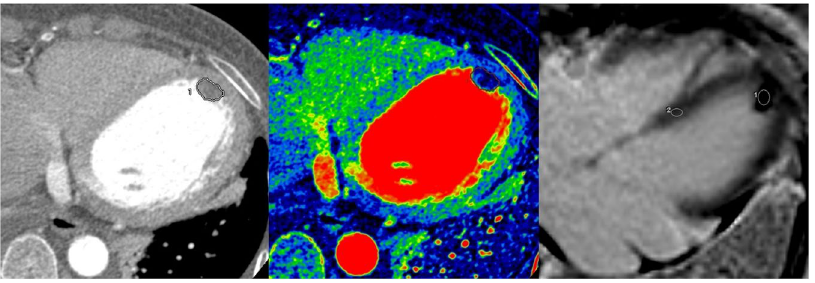
Subgroup analysis of the quantitative results. Differences in quantitative values were analyzed between benign (n = 15: myxoma [n = 9], cavernous hemangioma [n = 2], lipoma [n = 2], angiofibroma [n = 1]) and malignant tumors (n = 9: lymphoma [n = 4], metastasis [n = 5]). However, there was no significant difference in parame- ters between the benign and malignant tumors, including HU (69.02 ± 7.21 vs. 91.28 ± 14.00, p = 0.17), iodine concentration (2.31 ± 0.22 vs. 2.99 ± 0.42, p = 0.16), or SI ratio (4.72 ± 1.19 vs. 3.80 ± 2.56, p = 0.75). According to the tumor type, there were significant differences in the iodine concentration between myxomas and thrombi (3.33 ± 0.39 vs. 1.79 ± 0.26, p = 0.002) and metastasis and thrombi (2.96 ± 0.52 vs 1.79 ± 0.26, p = 0.042). The SI ratio was significantly different between myxoma and thrombi (10.30 ± 1.95 vs 1.43 ± 0.14, p = 0.001) and other